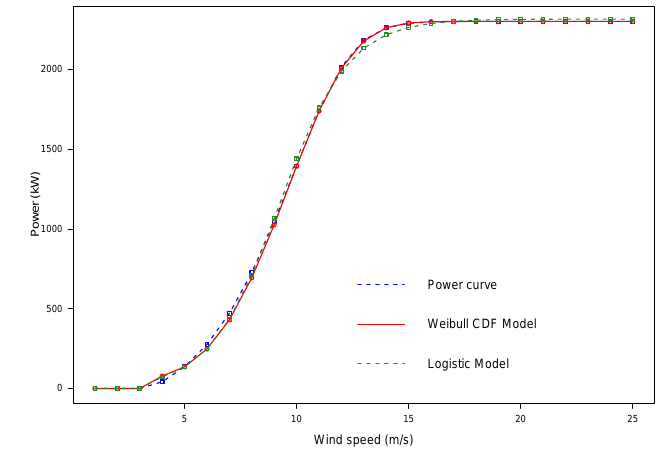
Figure 3. Weibull CDF and 4P-OP models for the Siemens 82 2-MW power curve.